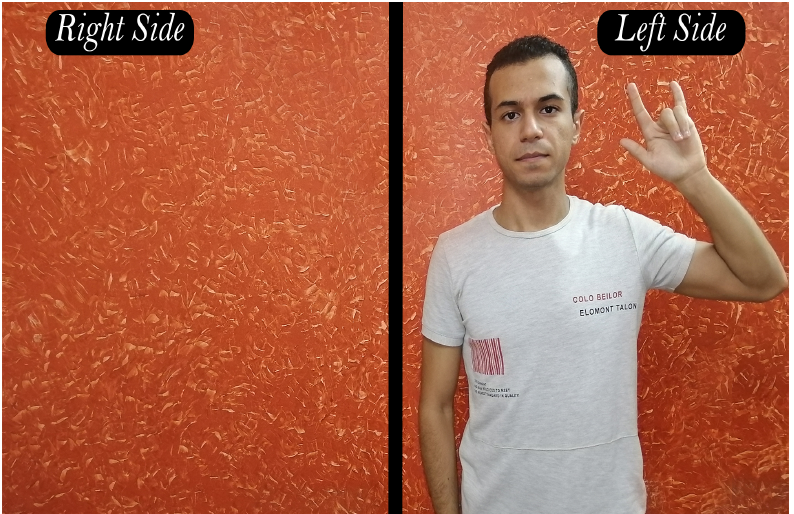
Figure 8. Body on the left-side of the frame. After the two preprocessing phases were finished, it was obtained that the dataset size has been increased while avoiding weakness at any sign, all dataset videos are balanced and unified, and the issues of body distance (depth) and body positioning have been resolved.